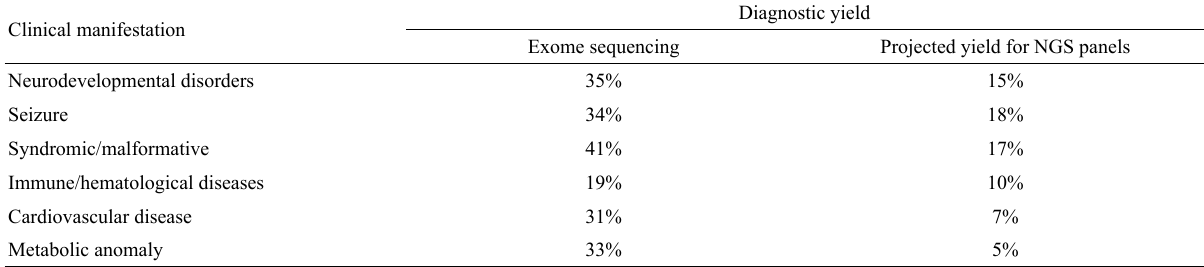
Table 2 ‒ Diagnostic yield of exome sequencing in our cohort of 500 patients with rare diseases (Quaio CRDC et al ., 2020) and projected diagnostic yield of NGS panels per clinical indication in the same cohort considering the rates of missed molecular diagnoses shown in Table 1.